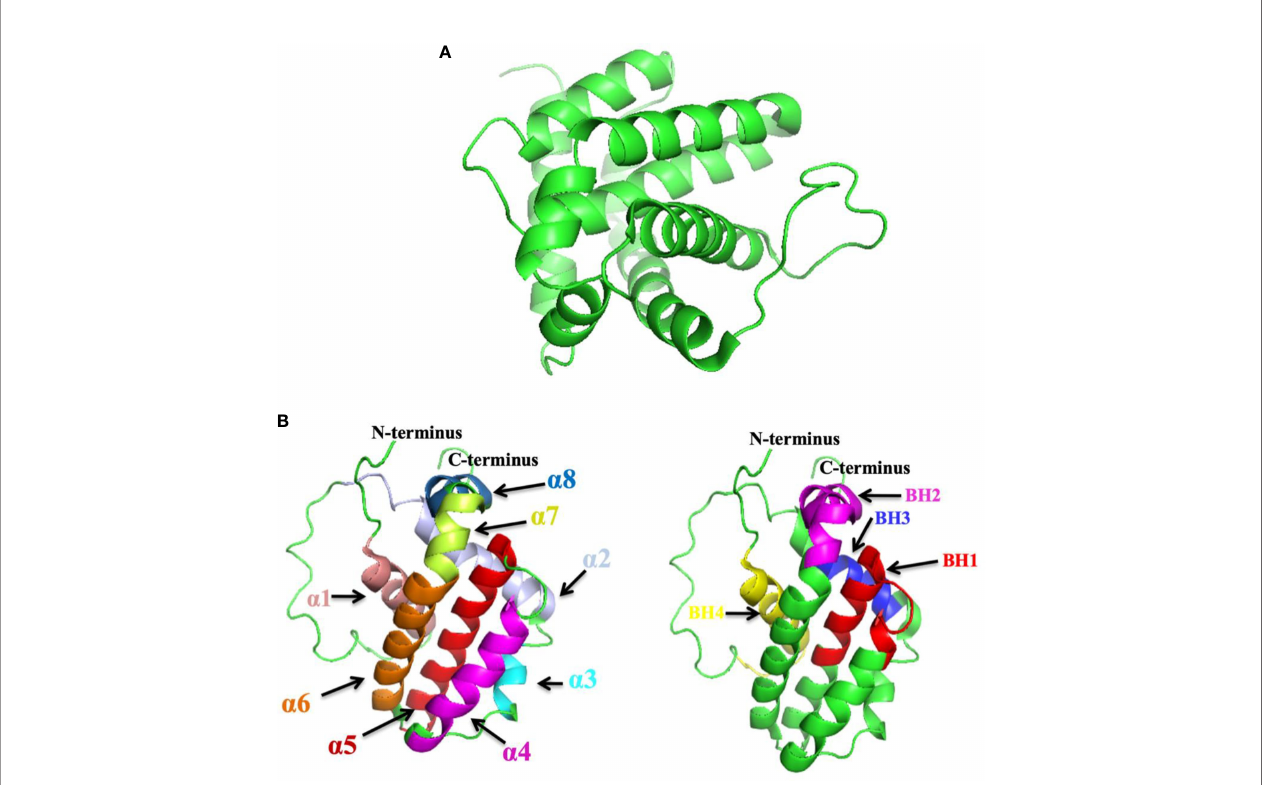
FIGURE 1 | (A) The tertiary structure of Bax (PDB ID: 1F16). (B) The tertiary structure of Bcl-2; highlighted sections indicate a -helices ( a 1 – a 8) and BH1-4 domains. However, the left panel denotes the Bcl-2 structure with a 1 – a 8 with several colors. The right panel denotes the Bcl-2 structure with the BH1-4 domains (PDB ID: 1G5M). (Structure was drawn by PyMol,